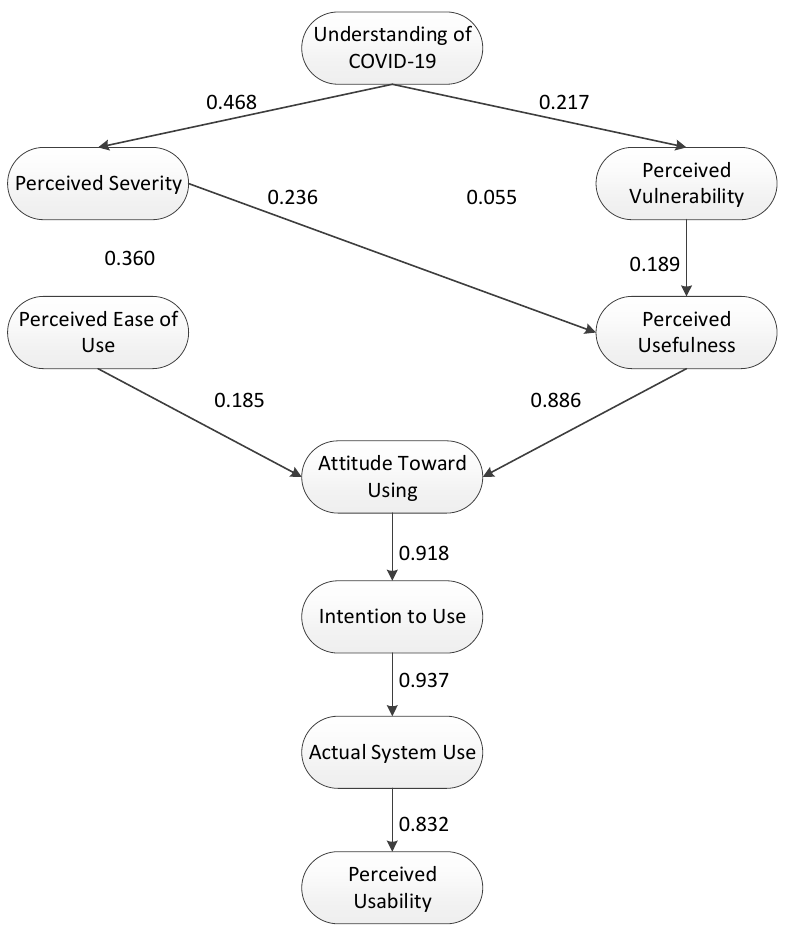
Figure 3. The final SEM for evaluating the perceived usability of the Thai Chana mobile application. Table 6. Direct effect, indirect effect, and total